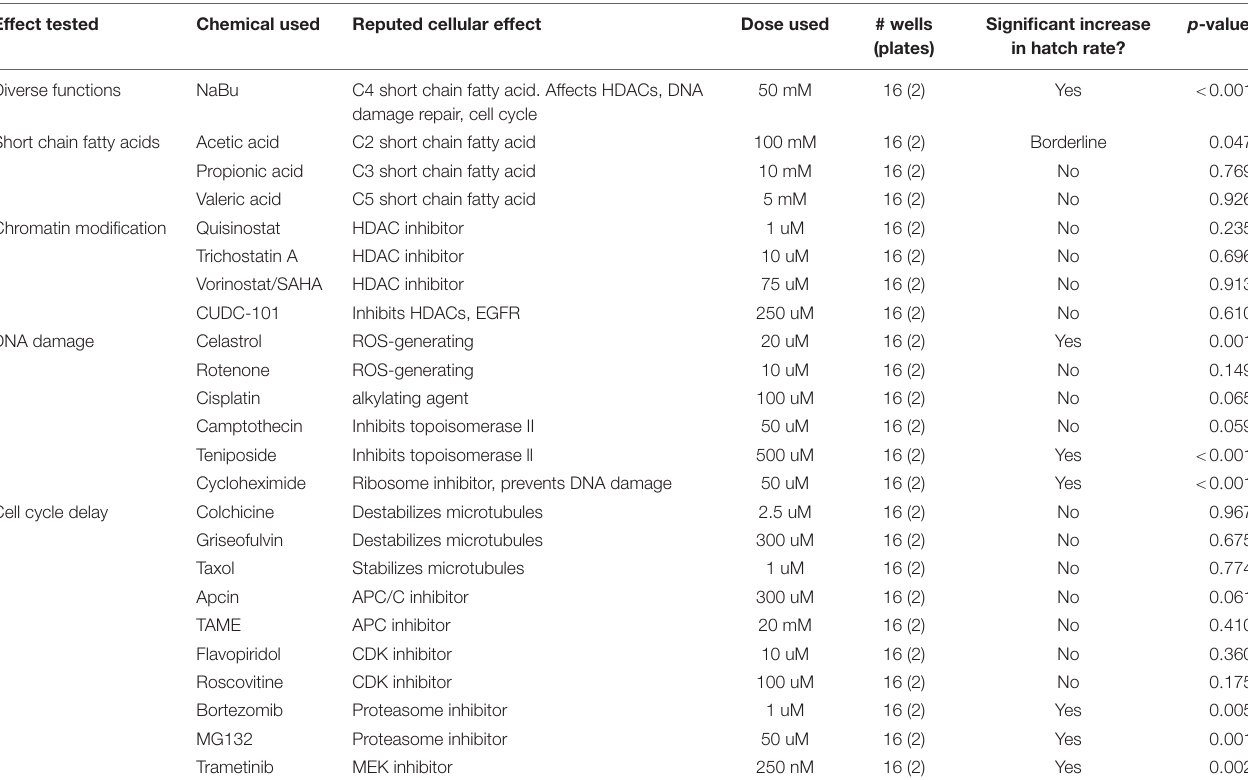
TABLE 3 | Impact of chemical treatments on CI egg hatch rates for w Ri-infected D. simulans. Effect tested